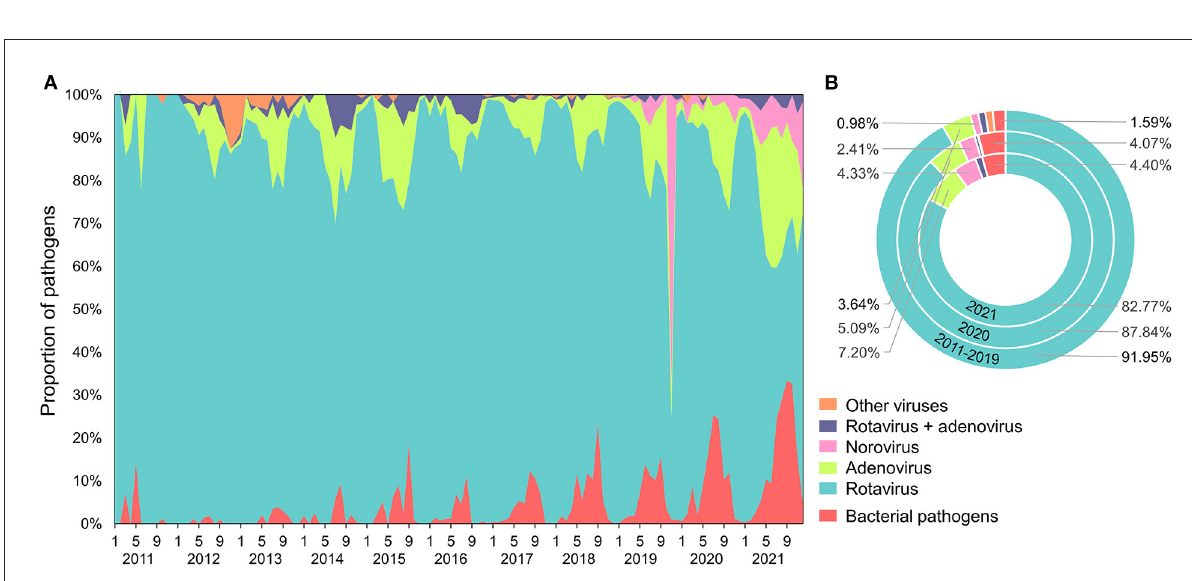
FIGURE2 (A) Weekly and (B) yearly proportion of pathogens responsible for infectious diarrhea in Xi’an from 2011 to 2021.